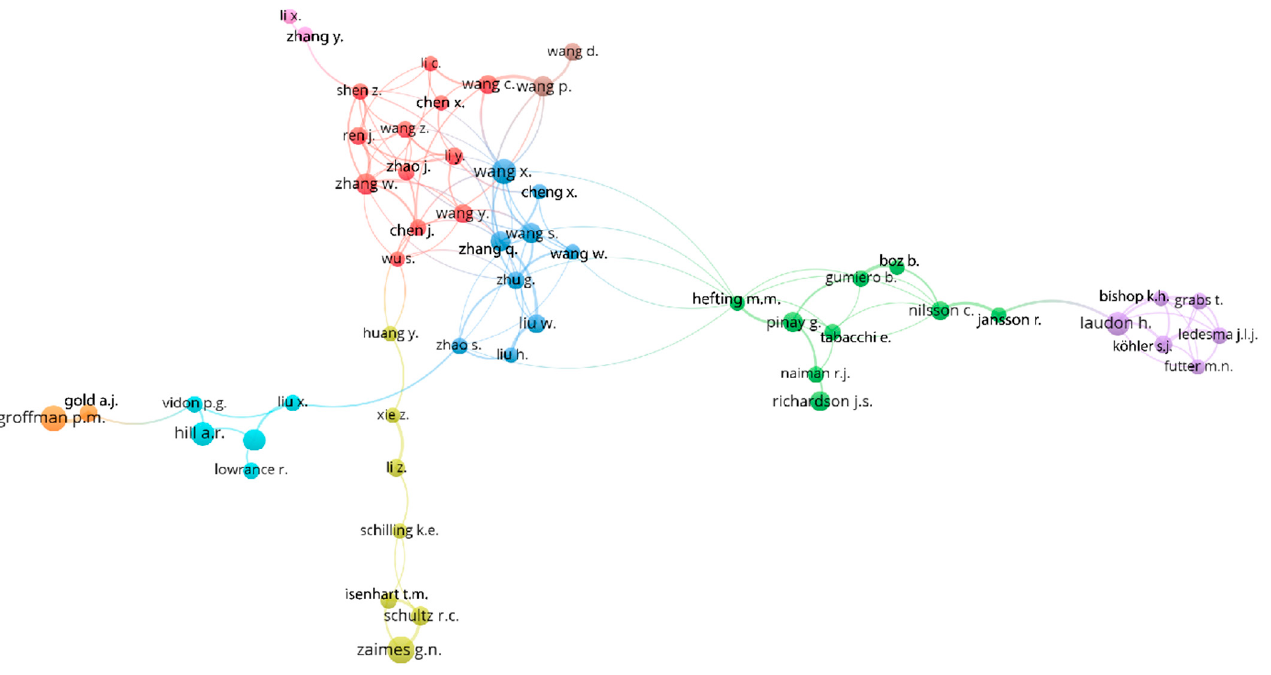
Figure 6. Co-authorship network. A threshold of 5 documents was applied, resulting in a total of 54 authors. The bubble size refers to the total number of publications. Line thickness and color refer to link strength and clustering, respectively.